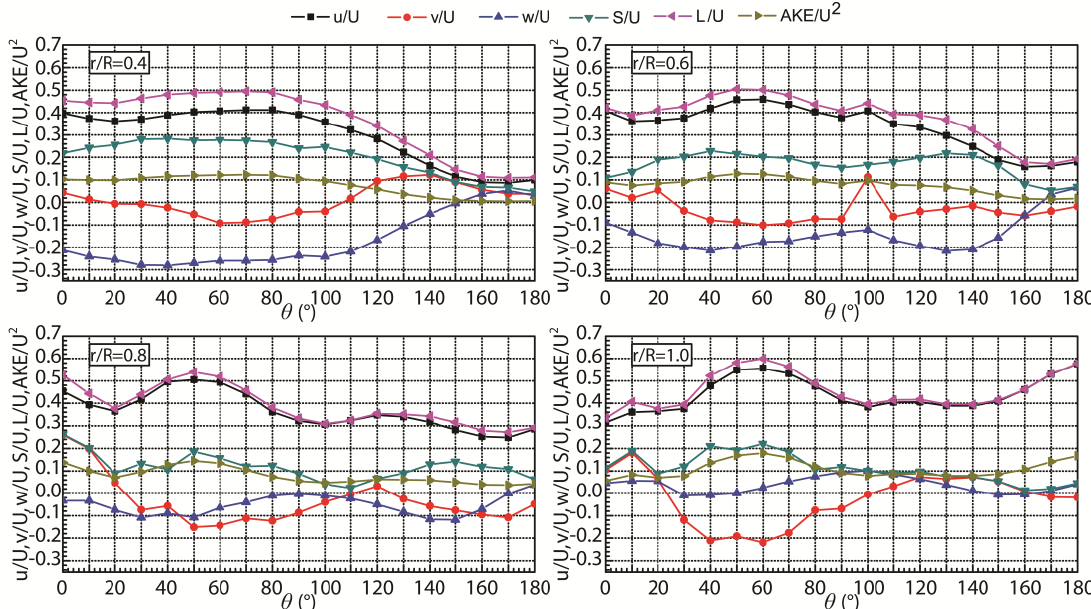
Figure 6. Time-averaged velocity and the average kinetic energy (AKE) profiles at each radius in the propeller region under the ballast